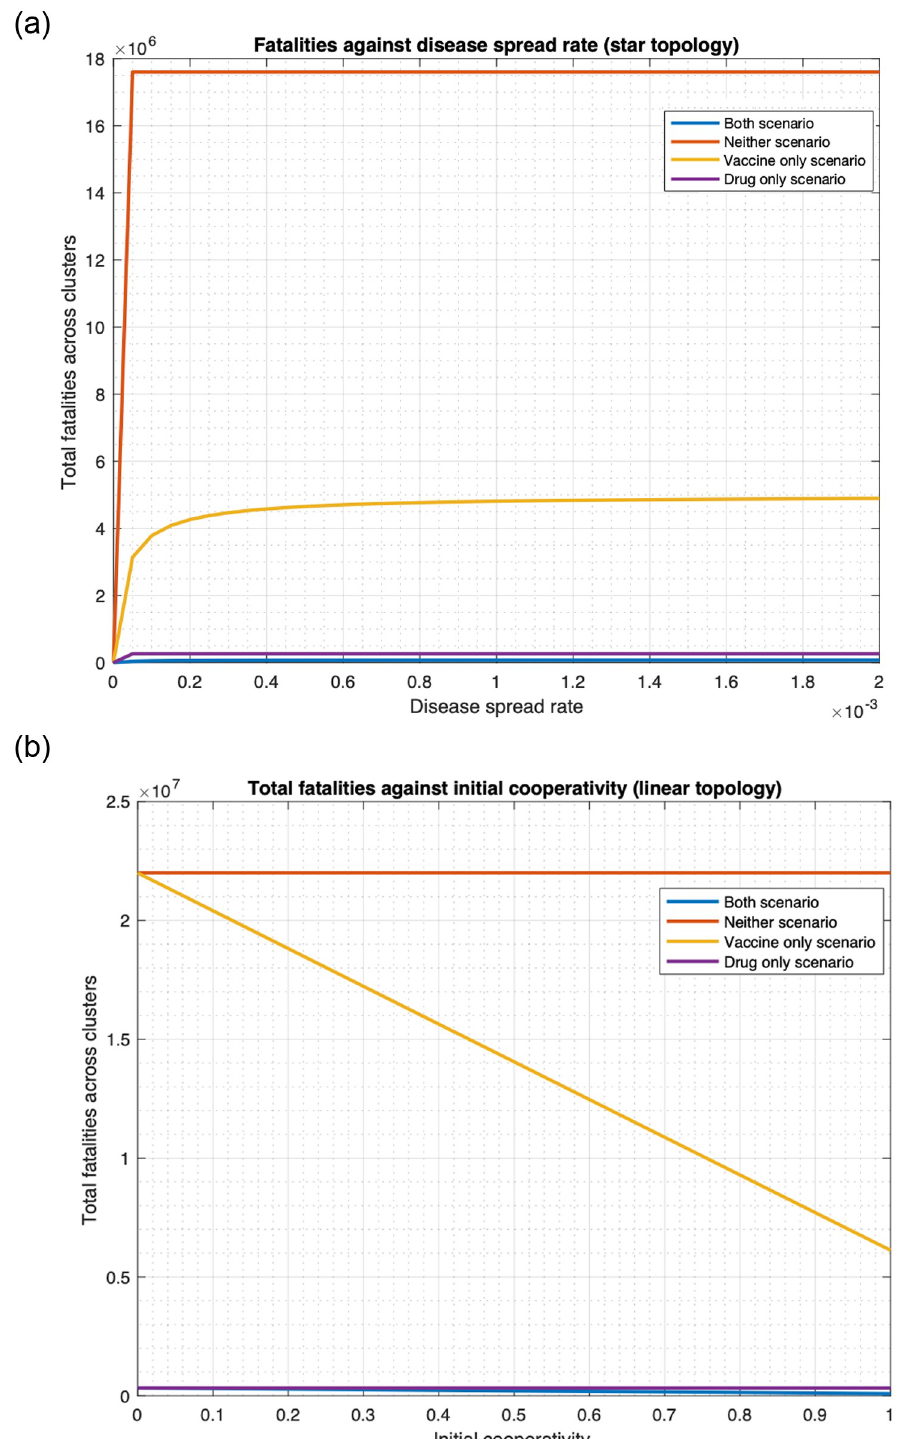
Fig 15. Fatalities under four countermeasure application scenarios for various values of infection spread rates and initial cooperativities for multiple clusters. (a) Relationship between total fatality and disease spread rate (star topology). (b) Relationship between total fatality and initial cooperativity (linear topology).